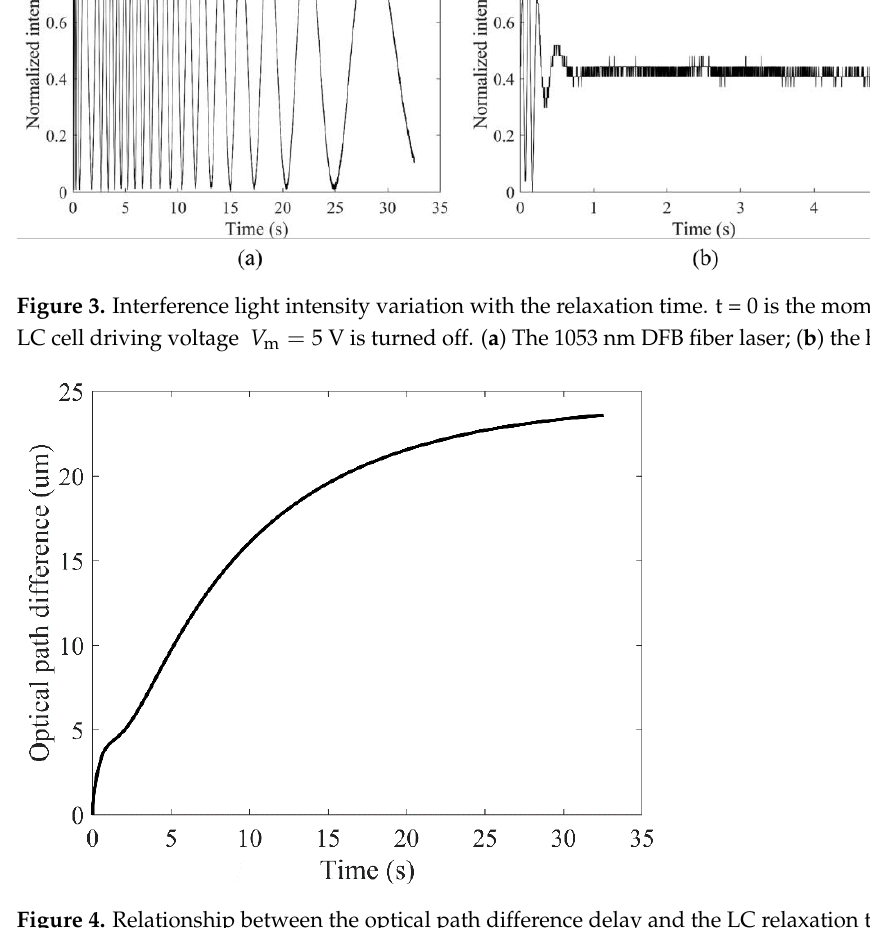
Figure 4. Relationship between the optical path difference delay and the LC relaxation time obtained at 1053 nm.